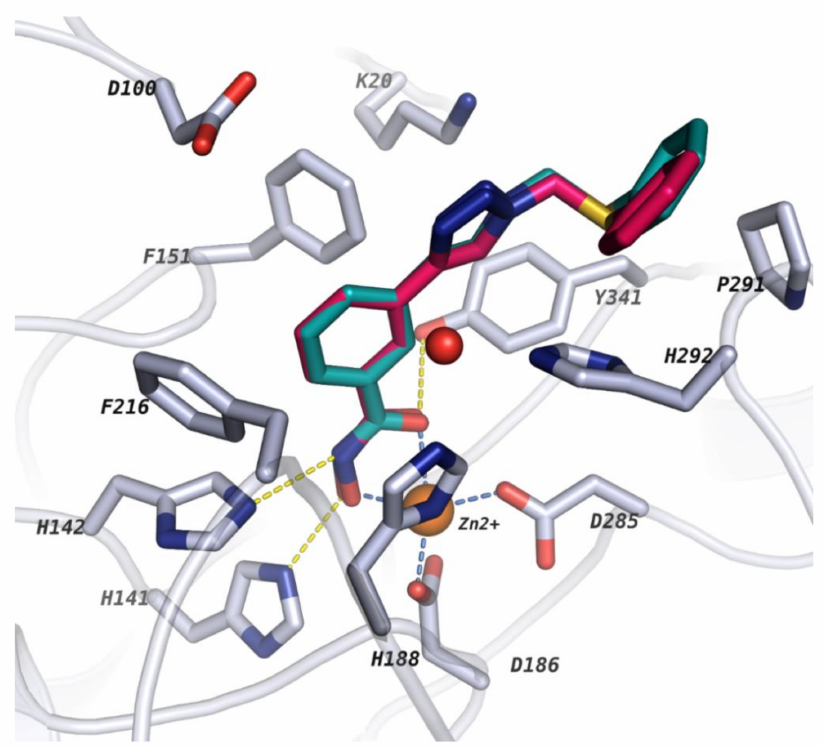
Figure 3. Re-docked pose in PDB code: 6HRQ. Crystallized ligand and re-docked ligand poses are shown in cyan and magenta, respectively. Protein backbone is shown as a cartoon (white ribbon) and side chains of key amino acid residues in the active sites are shown as white sticks. The catalytic zinc ion and conserved water molecule are shown as orange and red spheres,